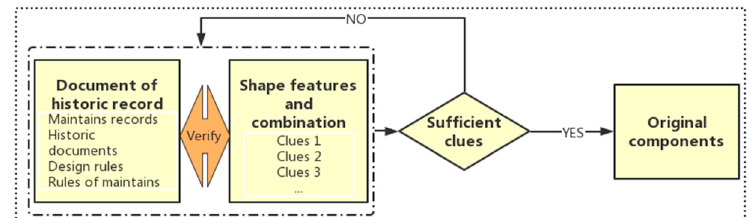
Figure 6. Identifying original components.